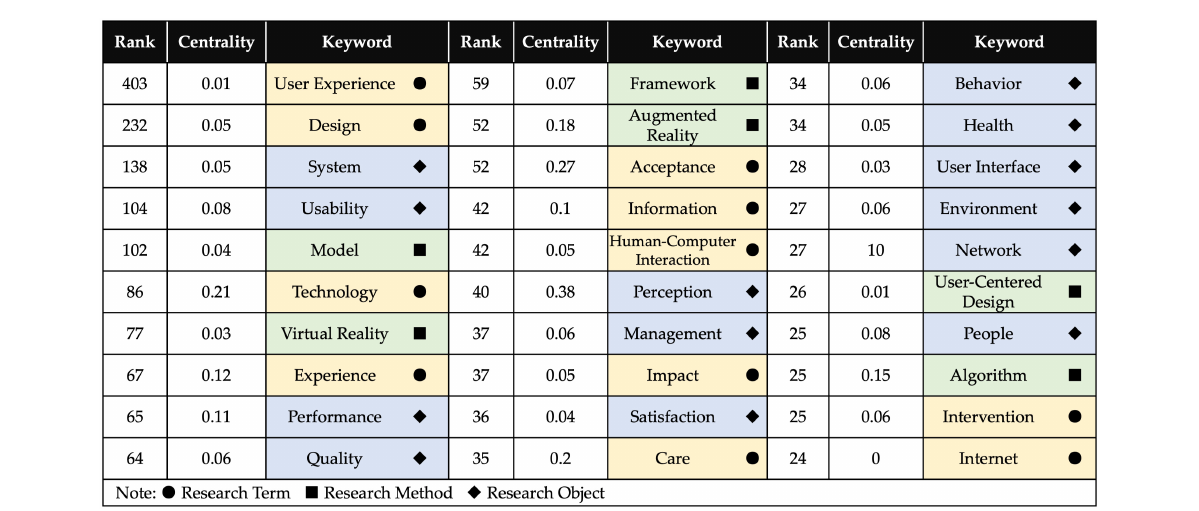
FIGURE7 Keywords attribute